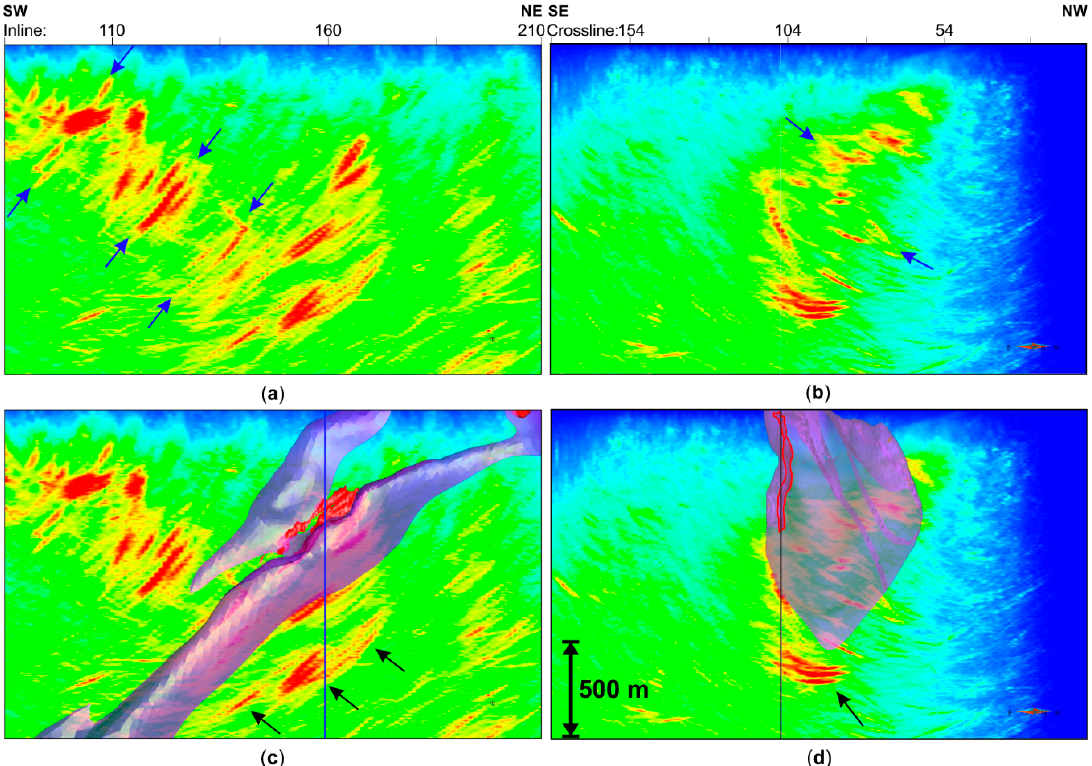
Figure 11. Crossline ( a ) and inline ( b ) extracted from the CBFVM sampled at 5 m (same version as in Figure 8b); ( c ) and ( d ) shows the data overlaid with the modelled base (from the borehole data) of the Kylylahti formation (in violet) and Kylylahti ore bodies (in red). See Figure 1 for location of the sections. The red line in (c) shows the inline position and yellow line in (d) shows the corresponding crossline position. The blue line in (c) shows the inline position and the black line in (d) shows the corresponding crossline position.